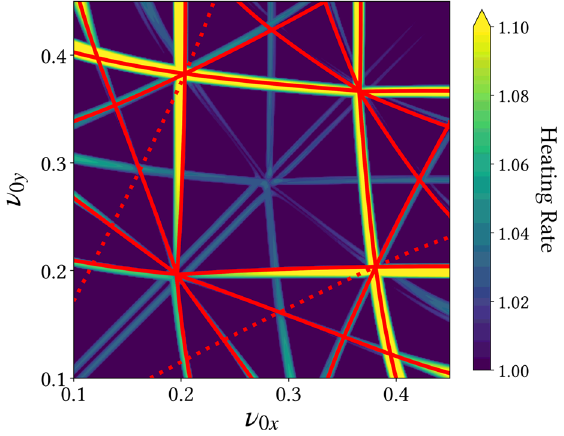
FIG. 2. Stability tune diagram obtained from the 2D Vlasov analysis based on the KV model (Ref. [1; 48] and [6]). All kinds of third-order ( m ¼ 3 ) space-charge terms have been taken into account to drive coherent resonances. The contributions from the quadrupole ( m ¼ 2 ) and other higher-order ( m ≥ 4 ) driving self- fields have been ignored. The initial condition is identical to what we assumed in Fig. 6 of Ref. [1] (the equipartitioning case) except that the beam density at the operating point ð ν 0 x ; ν 0 y Þ ¼ ð 1 = 6 ; 1 = 6 Þ has been increased to η ¼ η ¼ 0 . 8 here. Red lines x y represent the locations of the third-order resonance bands predicted by Eq. (1) with C 3 ¼ 0 . 85 . Two difference resonance bands (dotted line) have disappeared because, as pointed out in Ref. [1], the condition I k l ¼ 0 is fulfilled along them in an equipartitioned